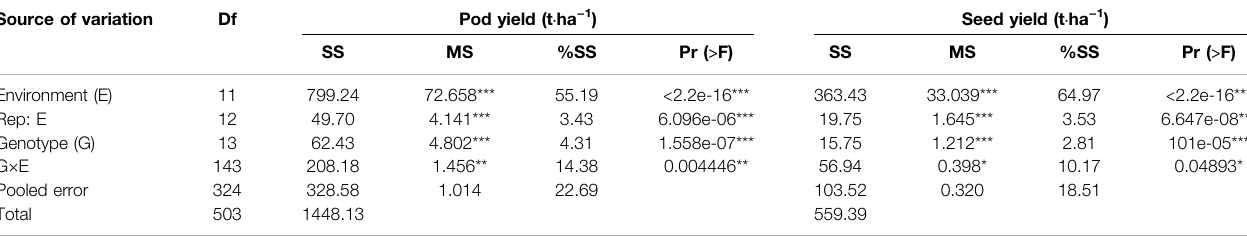
TABLE 1 | Combined analysis of pod yield and seed yield of 14 peanut lines tested across 12 locations. Source of variation